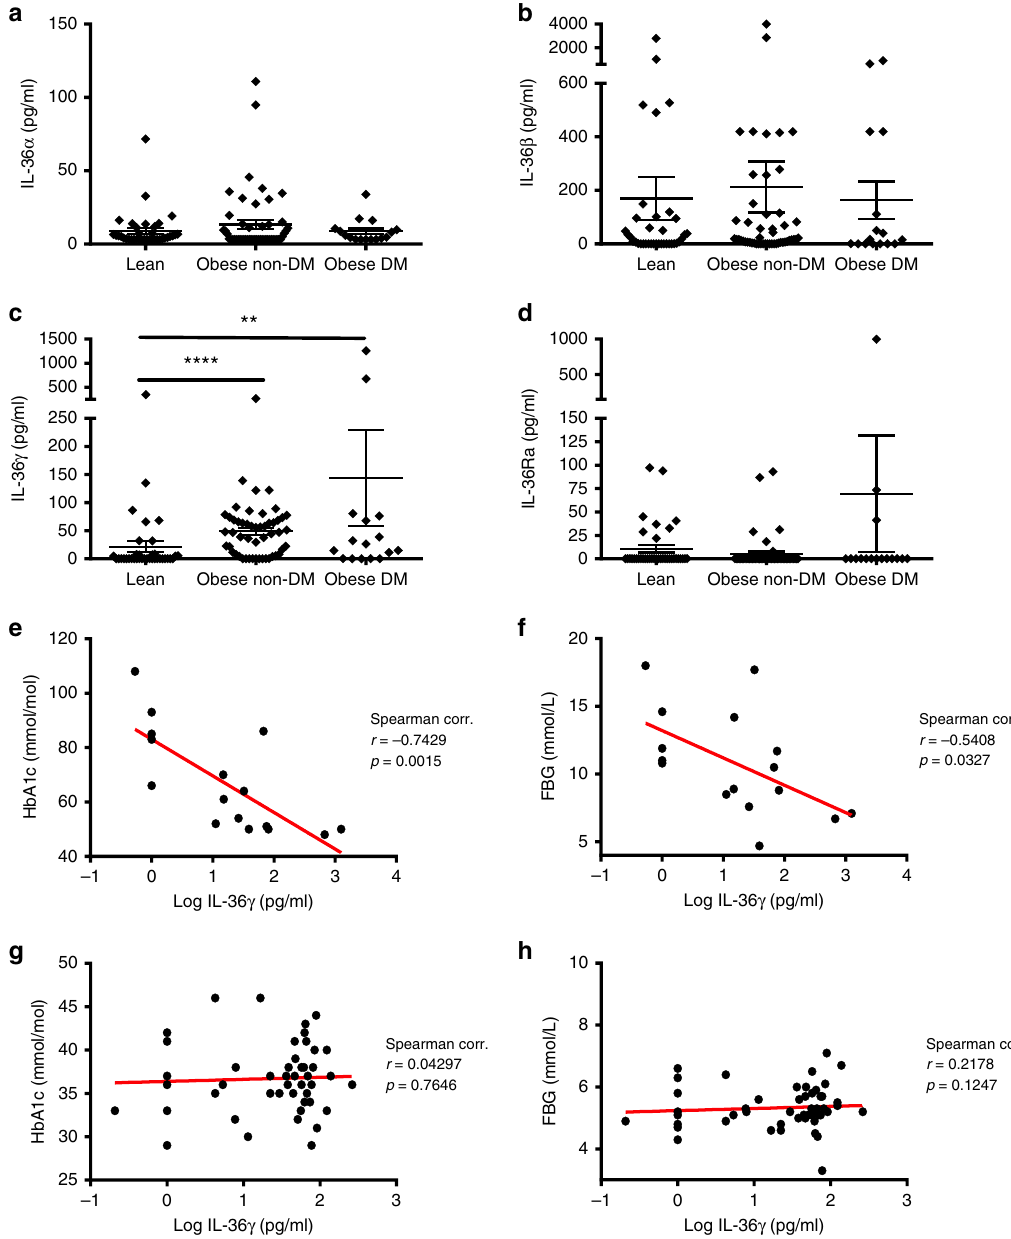
Fig. 1 IL-36 cytokine expression levels in the serum of obese patients. a – d IL-36 α , β , γ and IL-36Ra levels in the serum of lean individuals ( n = 37), obese non-diabetic patients (HbA1c < 48) ( n = 51) and obese with diabetes (HbA1c ≥ 48) ( n = 16), as measured by ELISA. e – h Correlation analysis of IL-36 γ levels with HbA1c and FBG in the serum of diabetic obese patients ( e , f ) and non-diabetic obese patients ( g , h ). Spearman correlation coef fi cient ( r ) and the corresponding p value shown. For ( a – d ) data are shown as means ± SEM, statistical analysis by two-tailed Mann – Whitney test, ** p < 0.01, **** p < 0.0001. DM: diabetes mellitus. Source data are provided as a Source Data fi